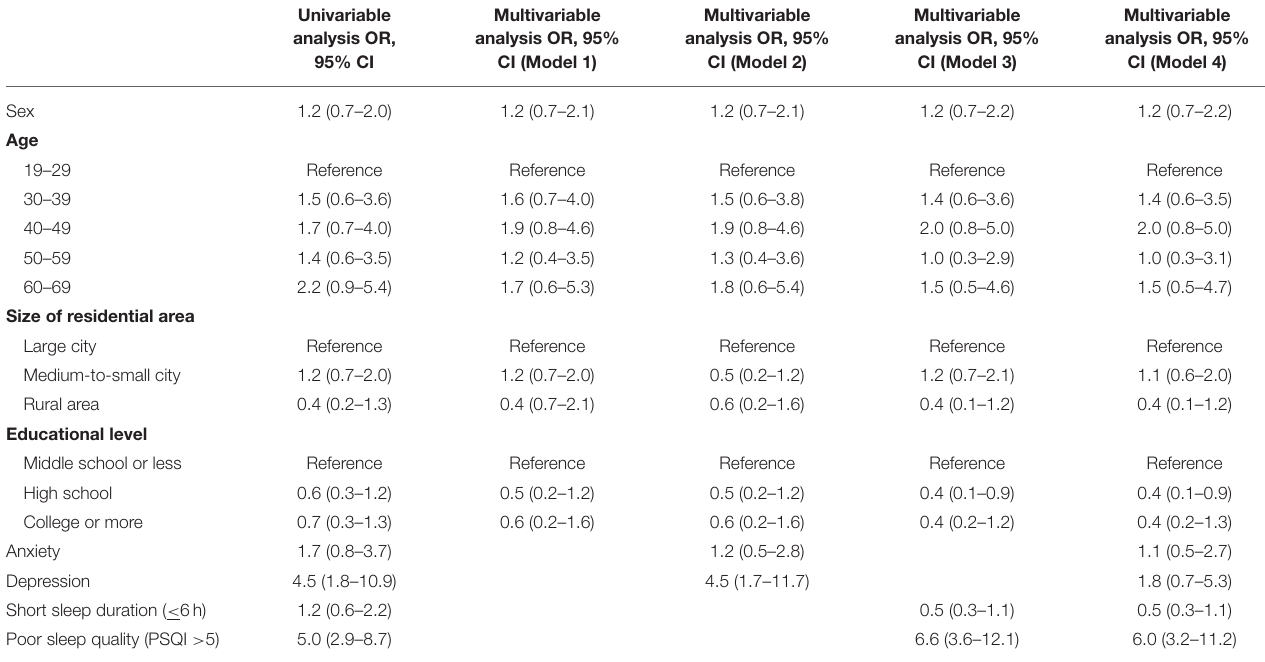
TABLE 3 | Logistic regression for the contributing factors of excessive daytime sleepiness (EDS) among individuals with tension-type headache